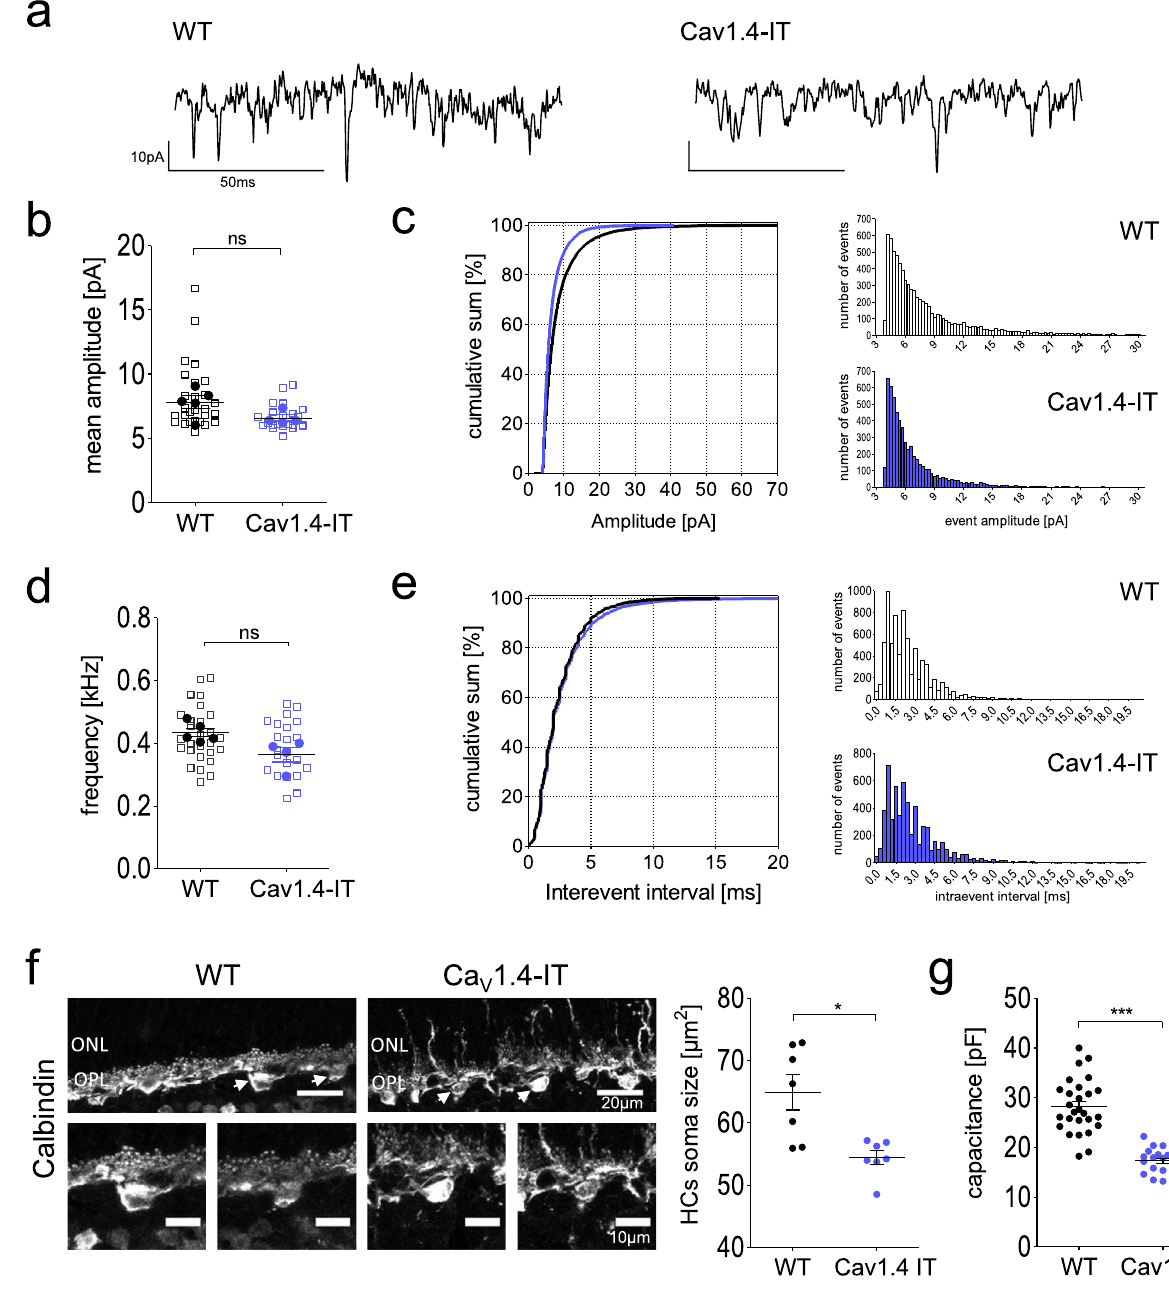
Figure 3. Horizontal cell activity as a readout of cone function. ( a ) Representative traces recorded from horizontal cell body of a wild type (WT, left) retina and Ca V 1.4-IT (right), 120 ms displayed. In ( b ), the mean amplitude [pA] is indicated for: WT: 7.8 ± 0.5, Ca V 1.4-IT: 6.64 ± 0.3. No statistical difference was found in a two-tailed Mann Whitney U-test. WT: N = 5; Ca V 1.4-IT: N = 4. ( c ) Left panel: cumulative sum of EPSC amplitudes recorded in WT and Ca V 1.4-IT horizontal cells; Statistics: ***, p < 0.001, two sample Kolmogorov–Smirnov test. Right panel: histogram of the amplitude distribution of WT (top, 7504 events from 24 cells) and Ca V 1.4-IT (bottom, 5653 events from 22 cells). Bin width, 0.3 pA. In ( d ) the mean frequency of the events recorded in WT (434.6 ± 13.9 Hz) and Ca V 1.4-IT (392.5 ± 11.1 Hz) showed no statistical difference in a two-tailed unpaired t-test. WT: N = 5; Ca V 1.4-IT: N = 4. ( e ) Left panel: cumulative sum of EPSC the intra-event interval. Right panels: histogram of the intra-event interval of WT (top, 7504 events from 24 cells) and Ca V 1.4-IT (bottom, 5653 events from 22 cells). Bin width, 0.3 ms. In ( b ) and ( d ), empty squares in the dot plot represent the average of 300 events from the same trace, the statistical analysis was, however, carried out for the means per animal (full circles). (f) Immunostaining of horizontal cells (calbindin) in WT and Ca V 1.4-IT retinas. Arrows mark the somas of the horizontal cells shown in the lower panels. ( g ) Left panel: horizontal cell soma size measurement from WT and Ca V 1.4-IT retinal sections also showed a reduction in the mean horizontal cell soma size [µm 2 ]: WT: 65.1 ± 2.2, N = 7, n = 47; Ca V 1.4-IT: 54 ± 1.5, N = 7, n = 42. Statistics: *, p = 0.0175, Mann Whitney U test. Right panel: extraction of whole-cell capacitance values (mean [pF] for WT: 28.2 ± 1.04; N = 27 and Ca V 1.4-IT: 17.4 ± 0.5, N = 23) indicated a reduction in horizontal cell size in Ca V 1.4-IT compared to wild type retinas. Statistics: ***, p < 0.0001, two-tail unpaired t-test. All data are presented as mean ±